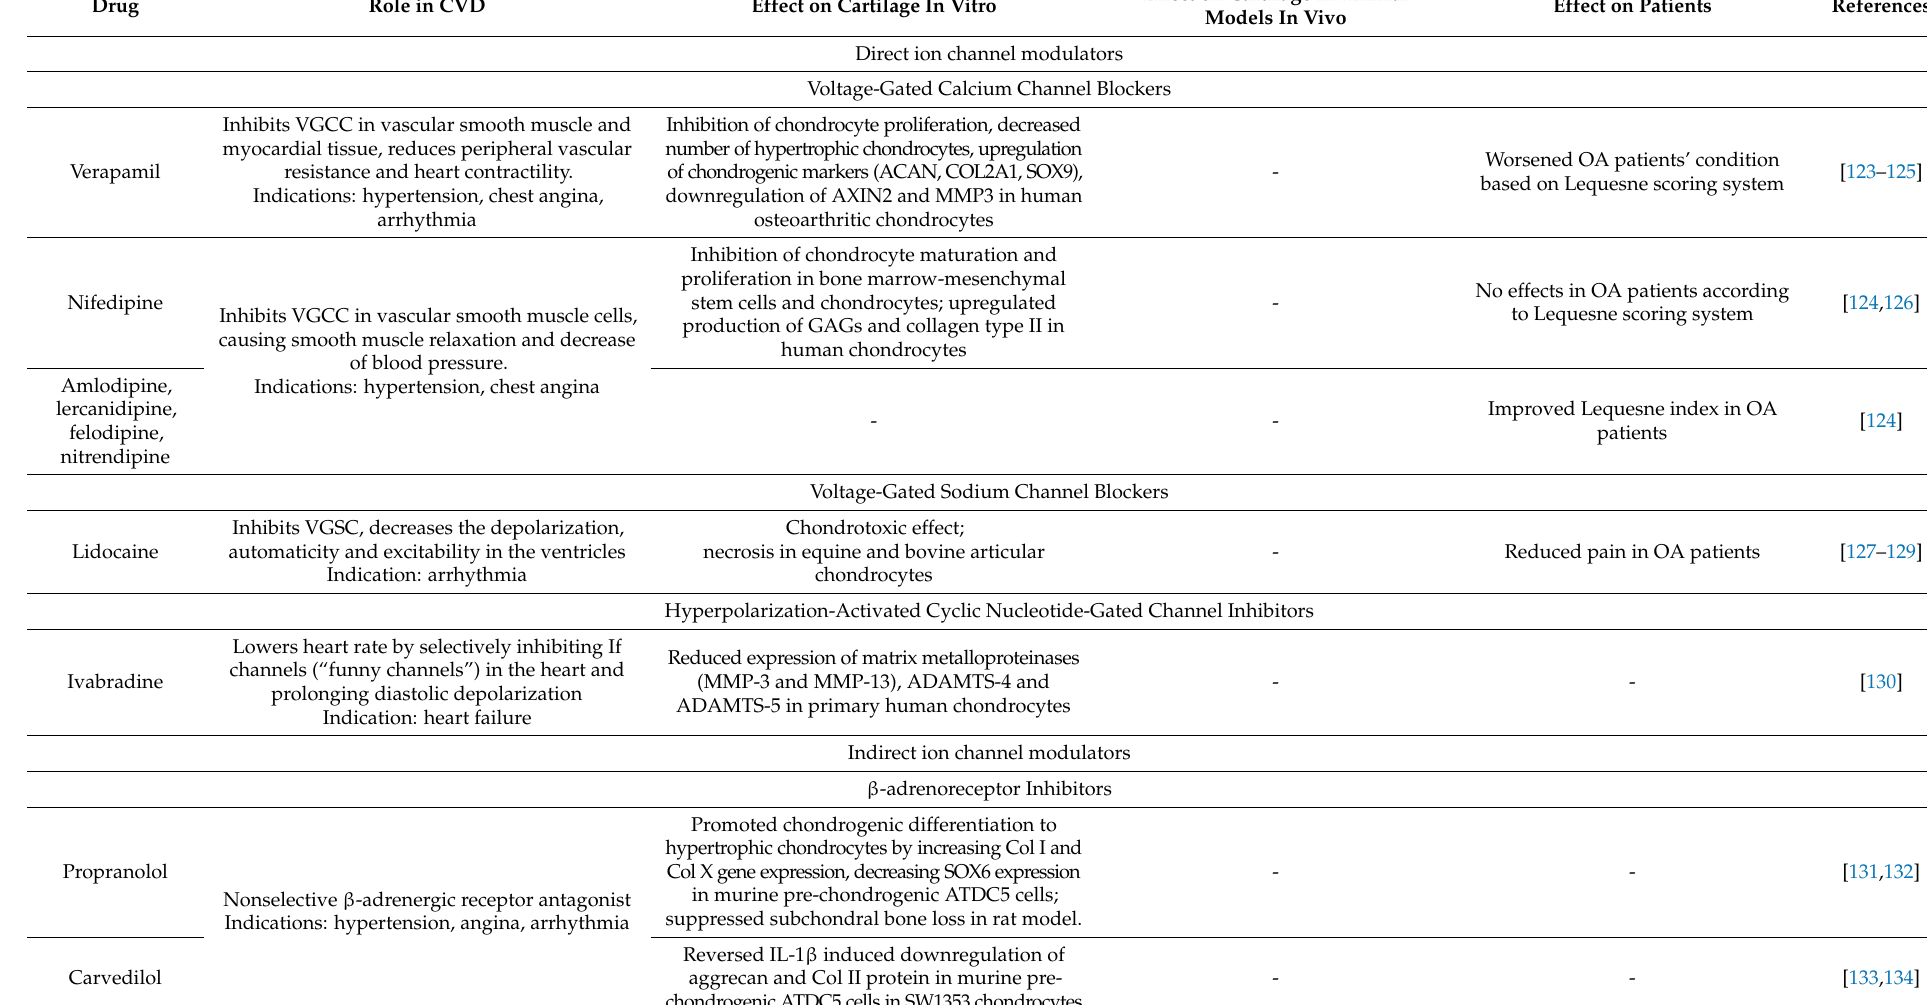
Table 1. Potential effects of the direct and indirect ion channel modulators used in treatment of CVD on the development of